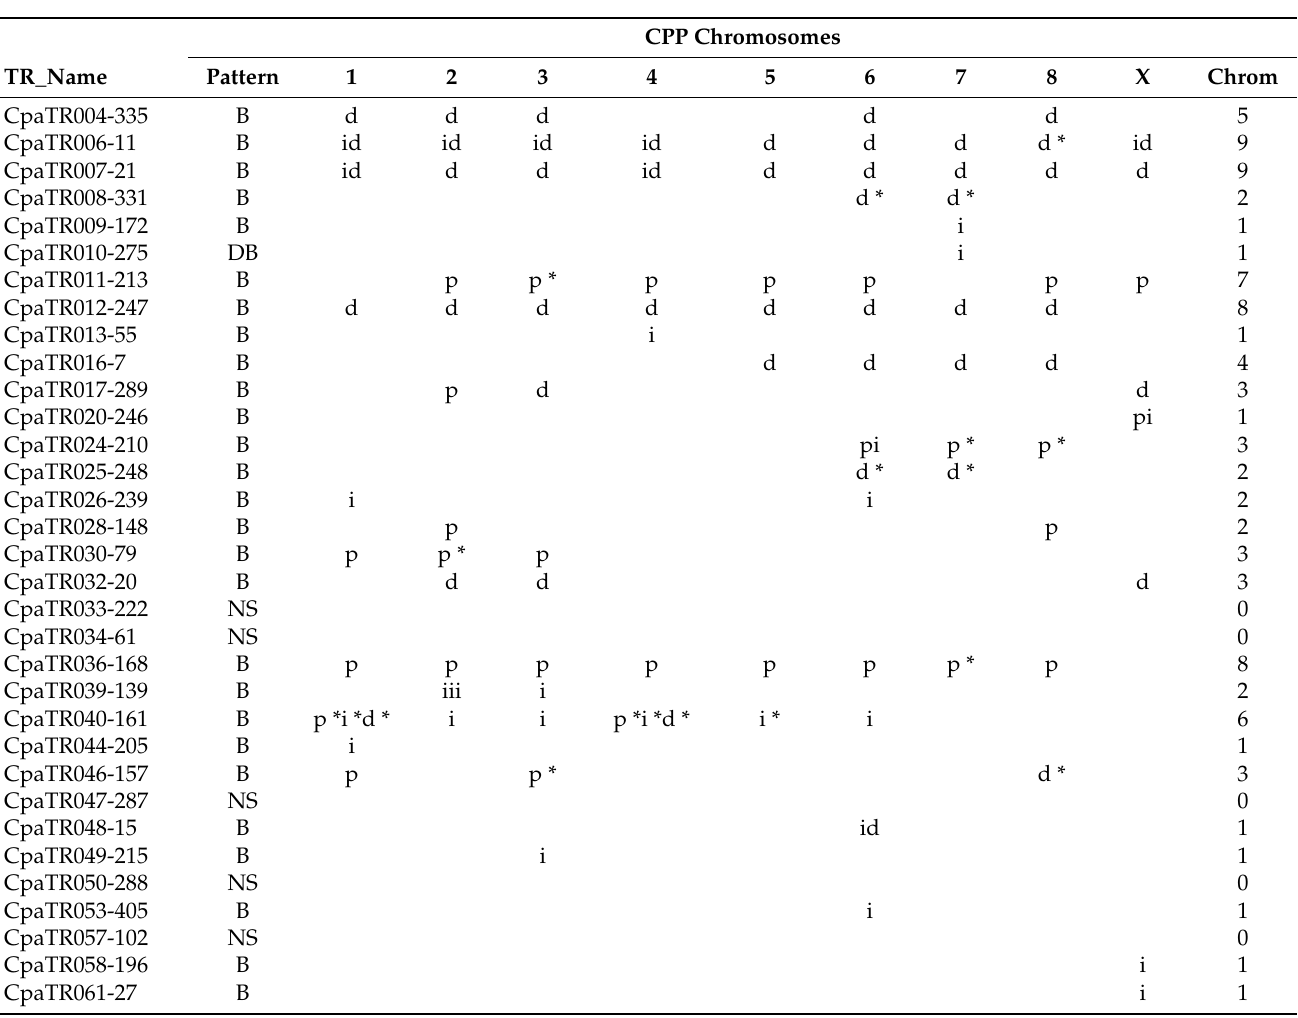
Table 2. Chromosome location of 50 TR families in the CPP subspecies of C. parallelus . Asterisks (*) indicate that bands were observed on only one member of a chromosomal pair. Chromosome location (pattern) could be pericentromeric (p), interstitial (i), or distal (d). B = banded, DB = dotted- banded, NS = no signal, Chrom = number of chromosomes displaying bands for a given TR family. CPP = Chorthippus parallelus parallelus . CPP Chromosomes